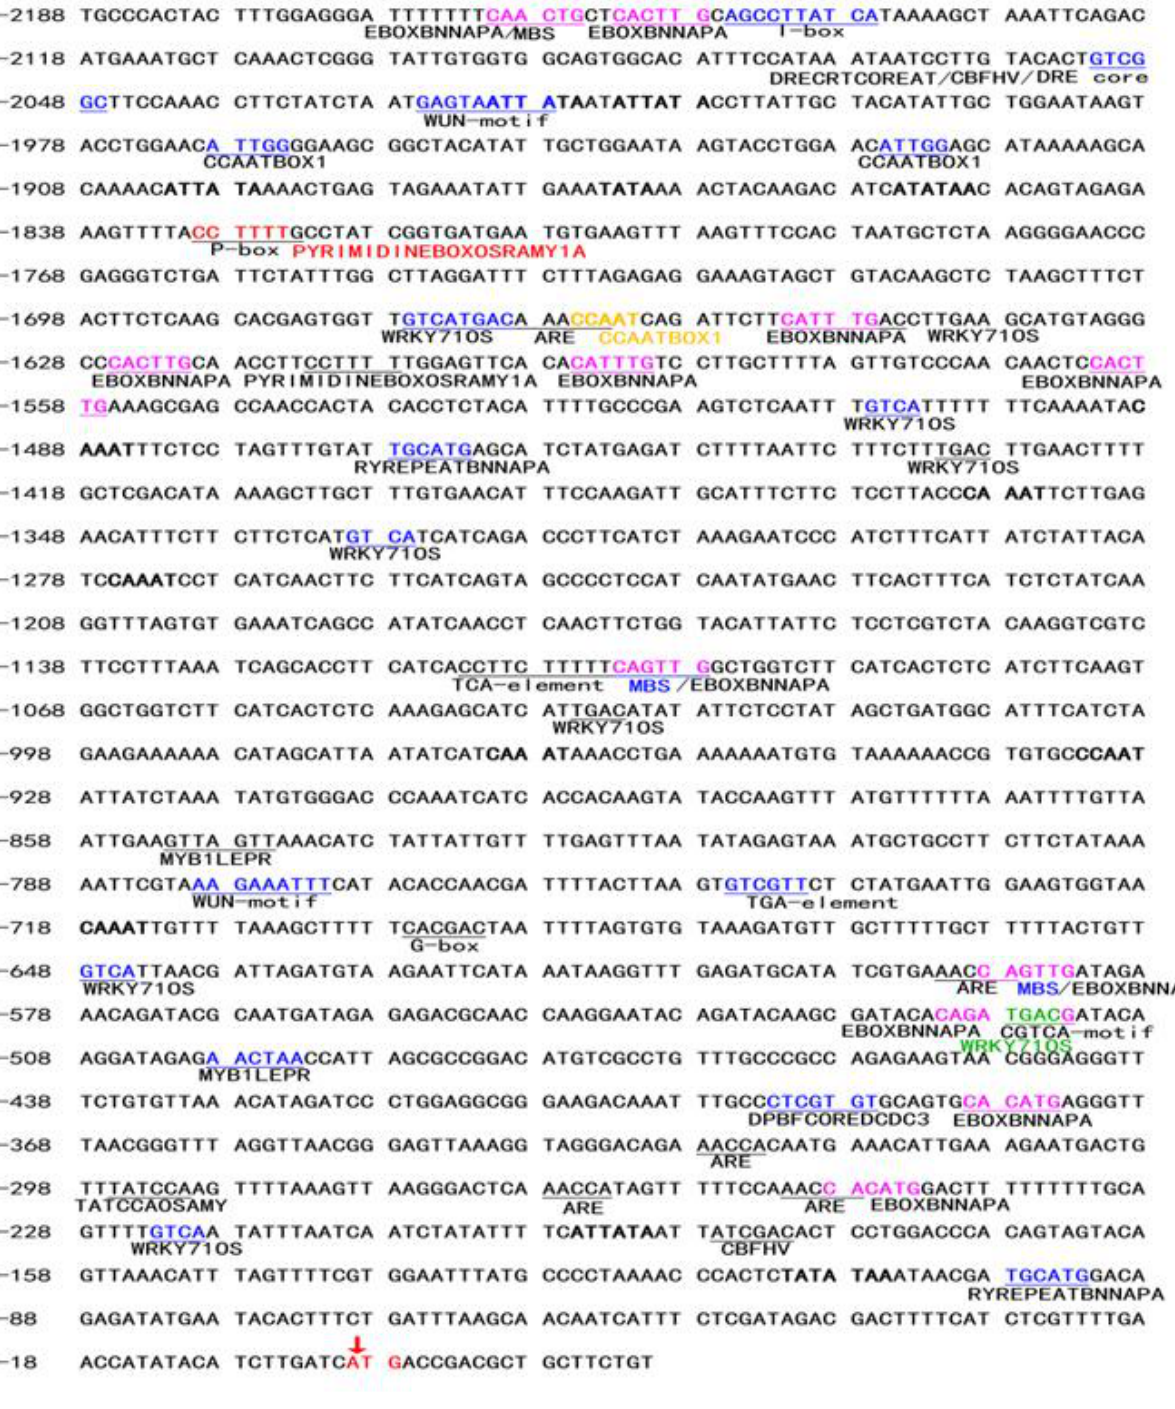
Figure 1. Physical map of the TkSRPP promoter. The “A” of the translation initiation code “ATG” of TkSRPP was designated as “+1”. The TATA-box is highlighted in bold. Putative cis -acting elements are underlined, colored and labeled. The cis -acting element sites on the negative strand and the double strands are shown in blue and pink, respectively. All the stress-responsive motives are represented by different colours.